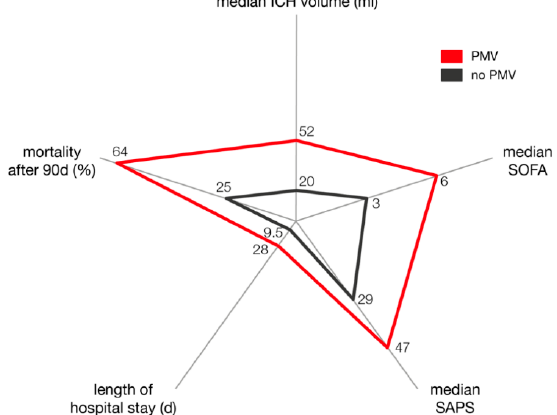
Figure 1. Graphical display of selected ICU admission data in PMV/non-PMV patients and corresponding impact on length of hospital stay and mortality after 90